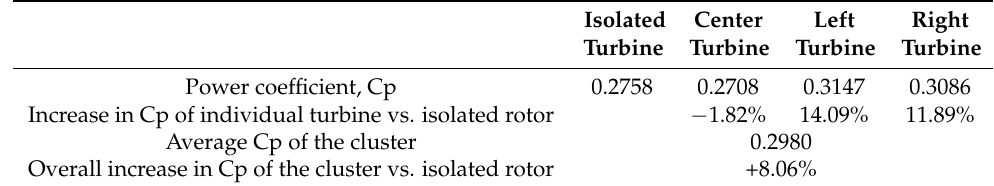
Table 5. Simulation results at 2 turbine diameter spacing.